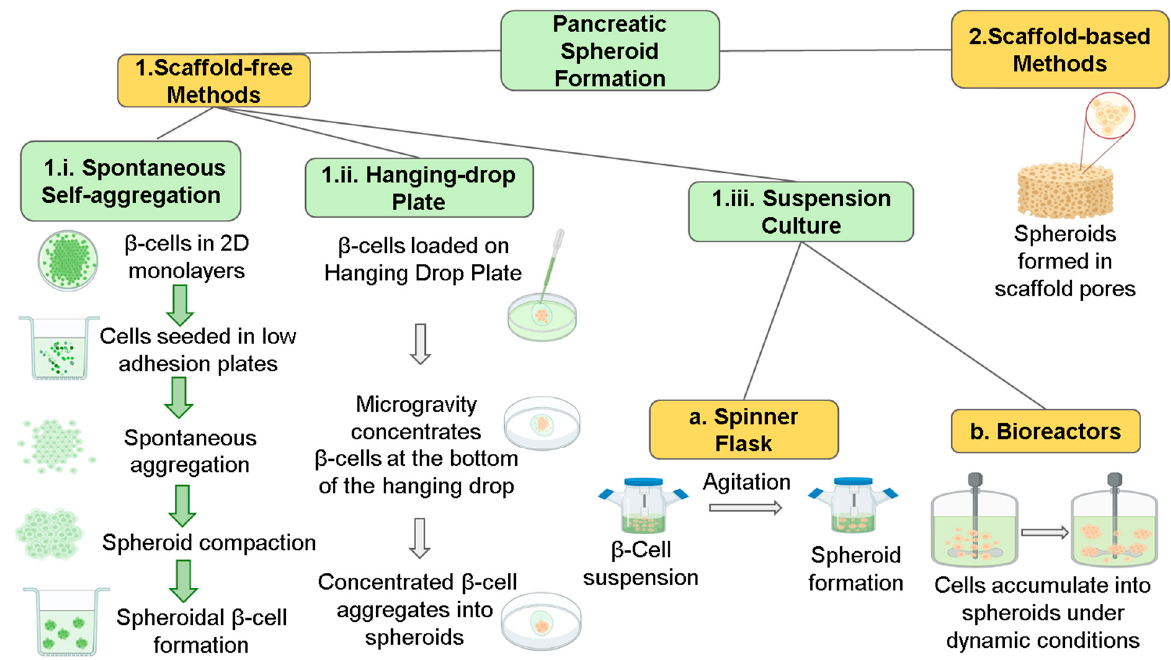
Figure 4. Methods to generate pancreatic 3D spheroids: Various methods to produce a 3D spheroid are adapted in diabetic research. The methods are broadly classified as scaffold-free methods, where the cells are formed as non-adherent aggregates that mimic their own solid extracellular matrix properties, and scaffold-based methods, where the cells are embedded in a matrix that influences the chemical and physical properties of the spheroids. In a spontaneous self-aggregation method, the spheroids are generated through seeding cells in ultra-low-adhesion plates that enable the achievement of spheroids with a defined geometry and facilitate high-throughput screening throughout the workflow. Spinner culture methods promote spheroid formation by keeping cells in suspension through agitation or by increasing the viscosity of the media, allowing spontaneous aggregation. The cells aggregate into droplets due to microgravity in the hanging-drop